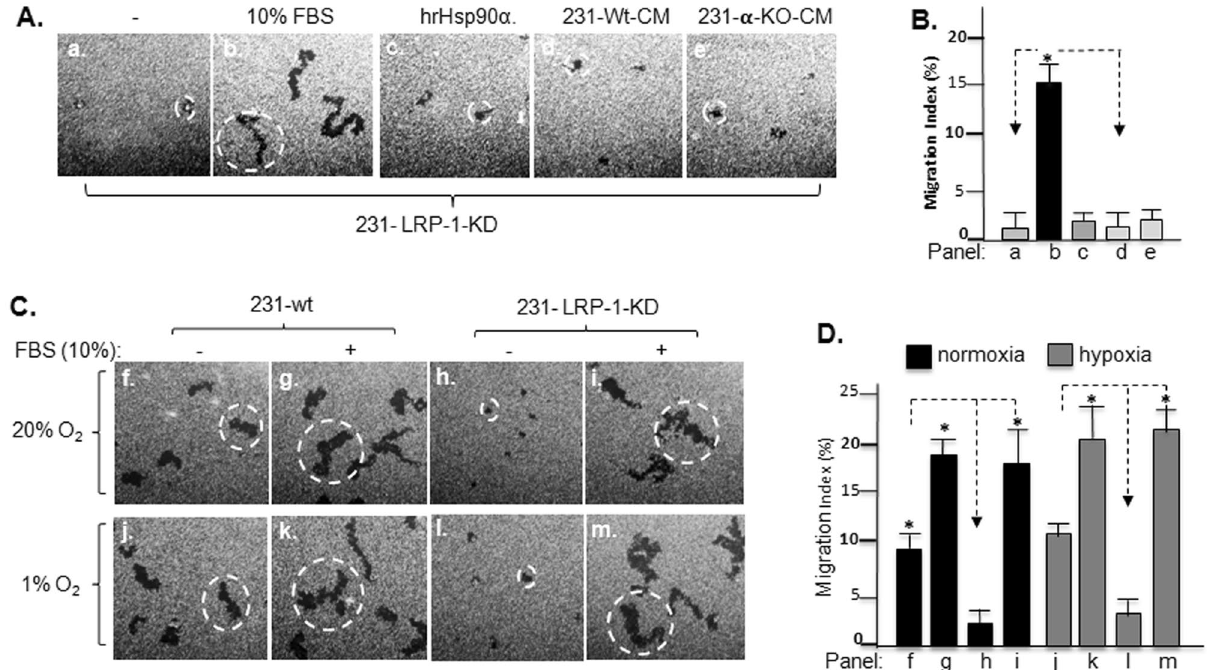
Figure 4. Only serum, but not 231-wt CM, hrHsp90α or hypoxia, rescues the blocked constitutive migration by LRP-1-KD. To further confirm that secreted Hsp90α in the “eHsp90α > LRP-1 autocrine loop” only presents a part of the tumour cells’ constitutive motility, all relevant extracellular factors were tested. ( A ) hrHsp90α protein (panel c), 231-wt CM (panel d) and 231-α-KO CM (panel e) all showed little effect, while serum (panel b) rescued as expected. ( B ) Computer-assisted quantitation of the migration data. ( C ) The indicated cell lines were serum-starved and subjected to colloidal gold migration assay un normoxia (20% O 2 ) or hypoxia (1% O 2 ) (a main driver of Hsp90α secretion 7 ) without or with FBS (10%). Dotted circles indicate that the average size of the migration tracks under each condition. ( D ) Computer-assisted quantitation of the migration data shows limited rescue of LRP-1-KD cell motility by hypoxia (panel l vs. panel